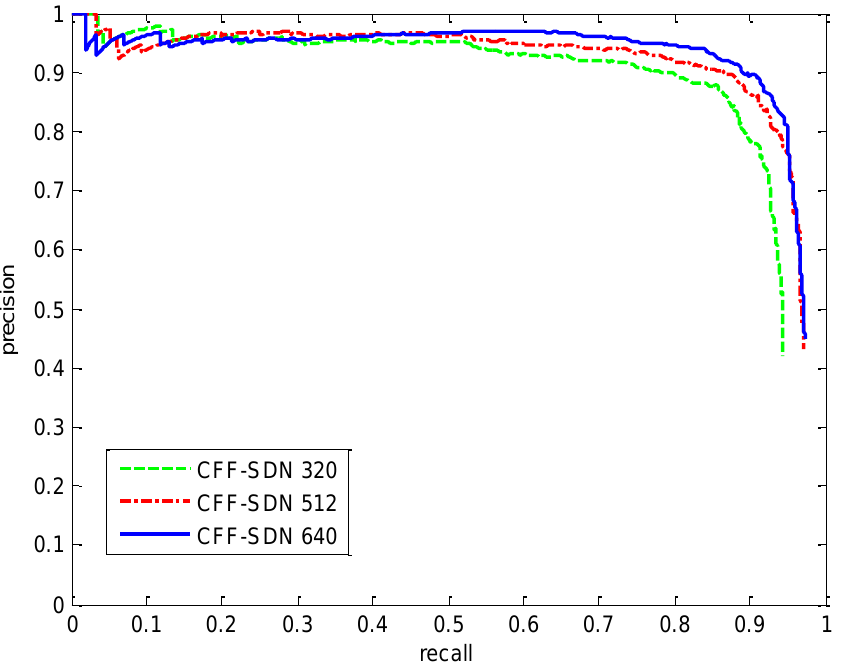
Figure 19. Precision–recall curves of CFF-SDN model for different image sizes .